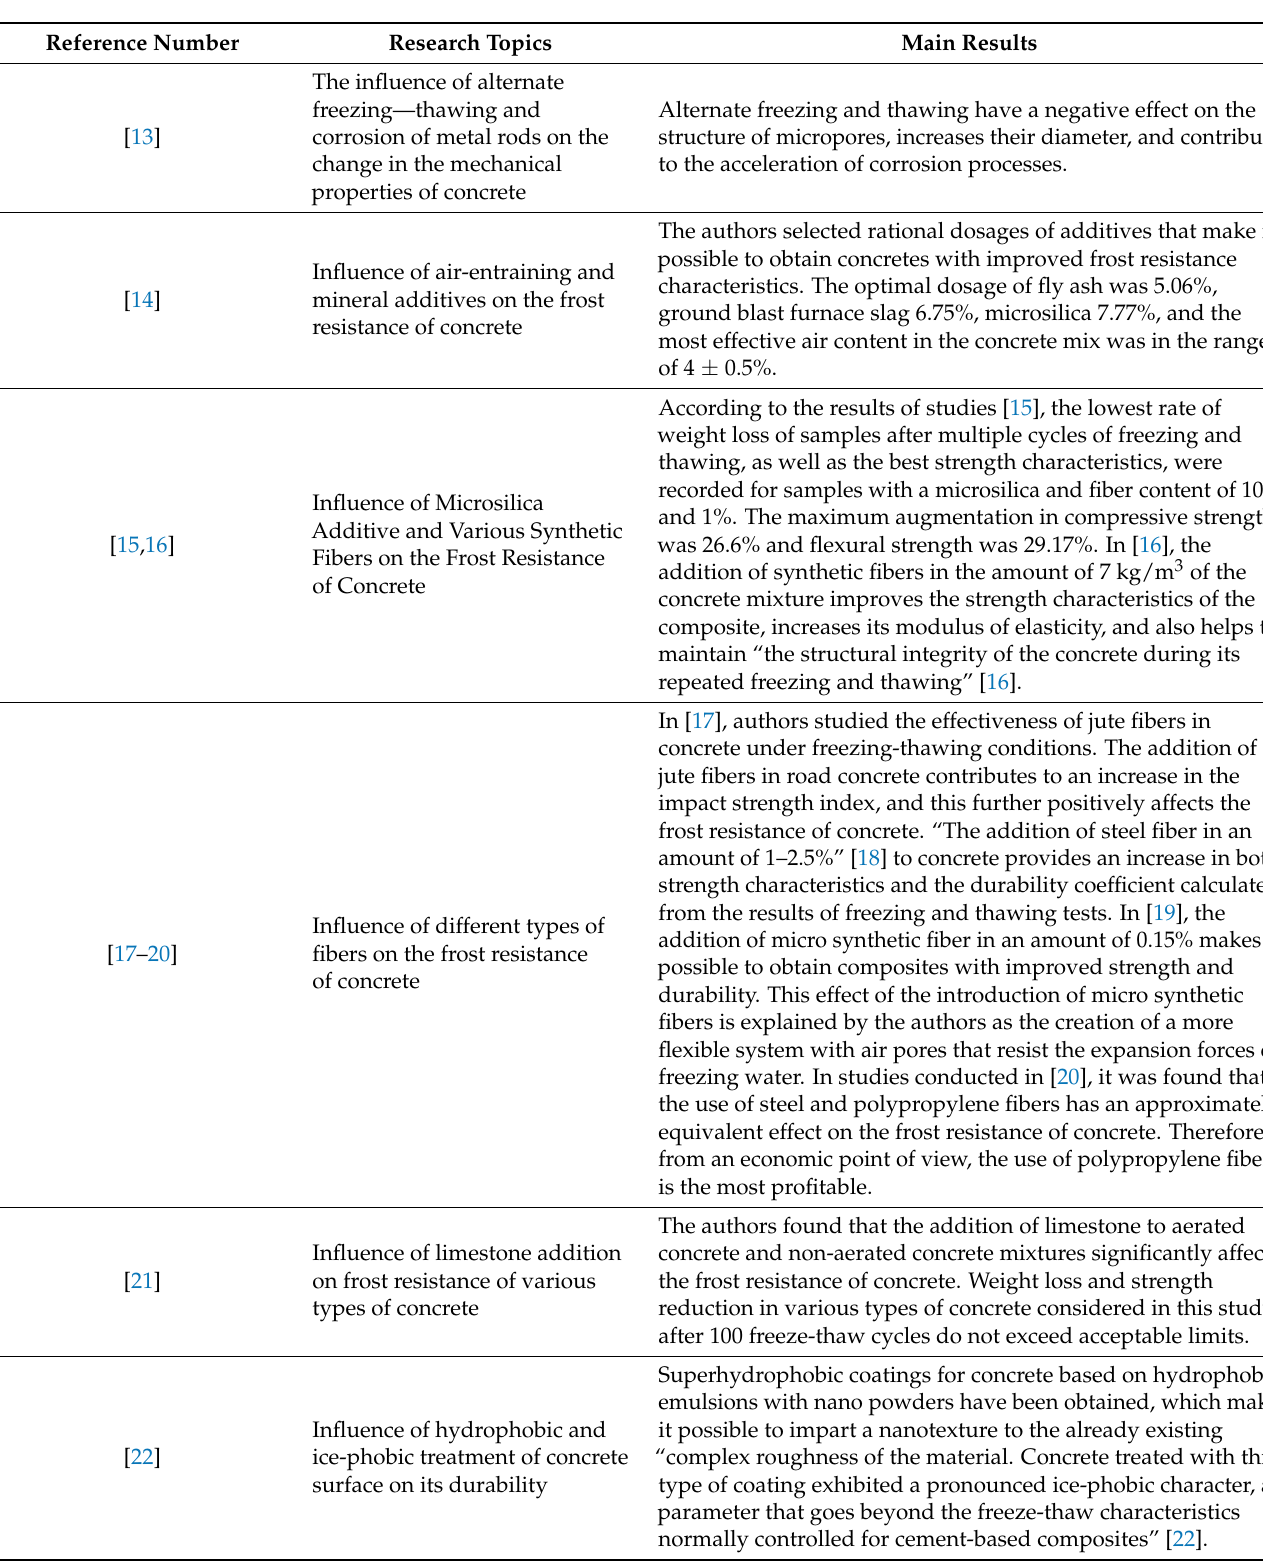
Table 1. Overview of studies on the topic of frost resistance of concrete and ways to improve